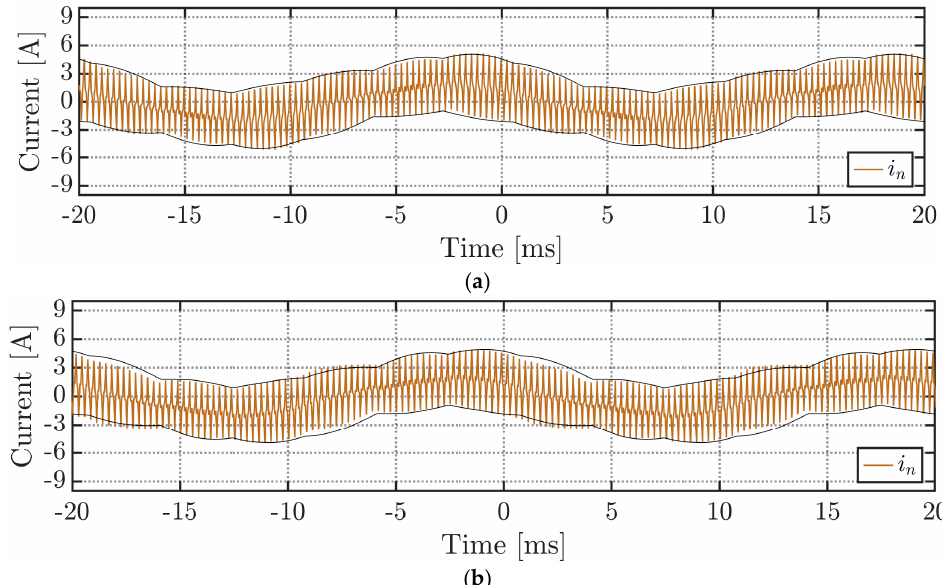
Figure 17. Instantaneous neutral currents for a phase magnitude unbalanced case with their primary (black) current ripple envelopes for SPWM ( a ) and CPWM ( b ) modulation strategies.